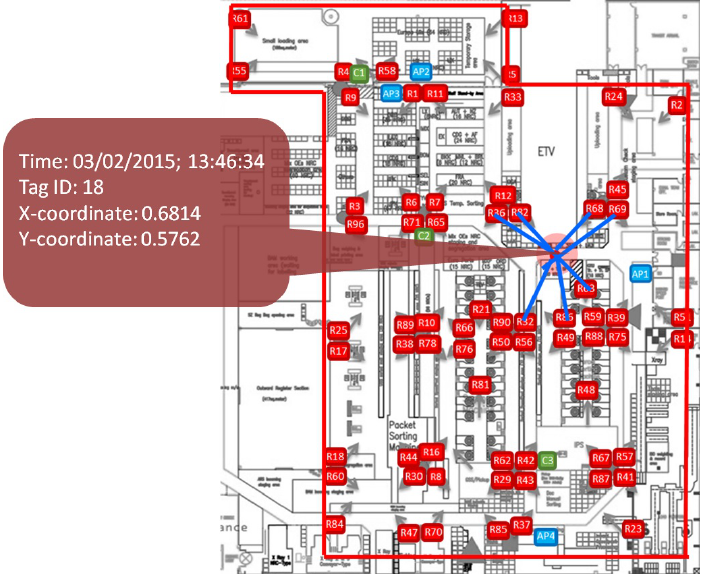
Figure 6. The above example illustrates the idea of using the antenna arrays and the angles of signal arrivals for positioning computation. Information about the transaction such as the time stamp, RFID tag ID and the location is also stored into the AMC information